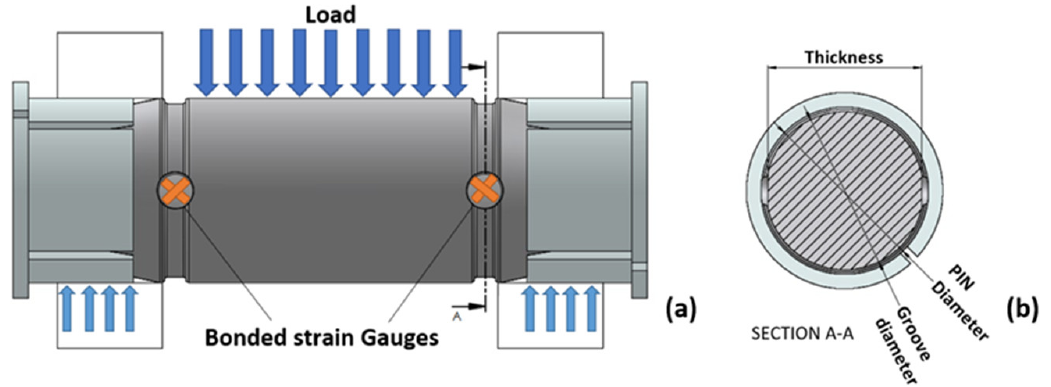
Figure 3. ( a ) Strain gauges on loaded expanding pin, and ( b ) cross-sectional area at grooves.